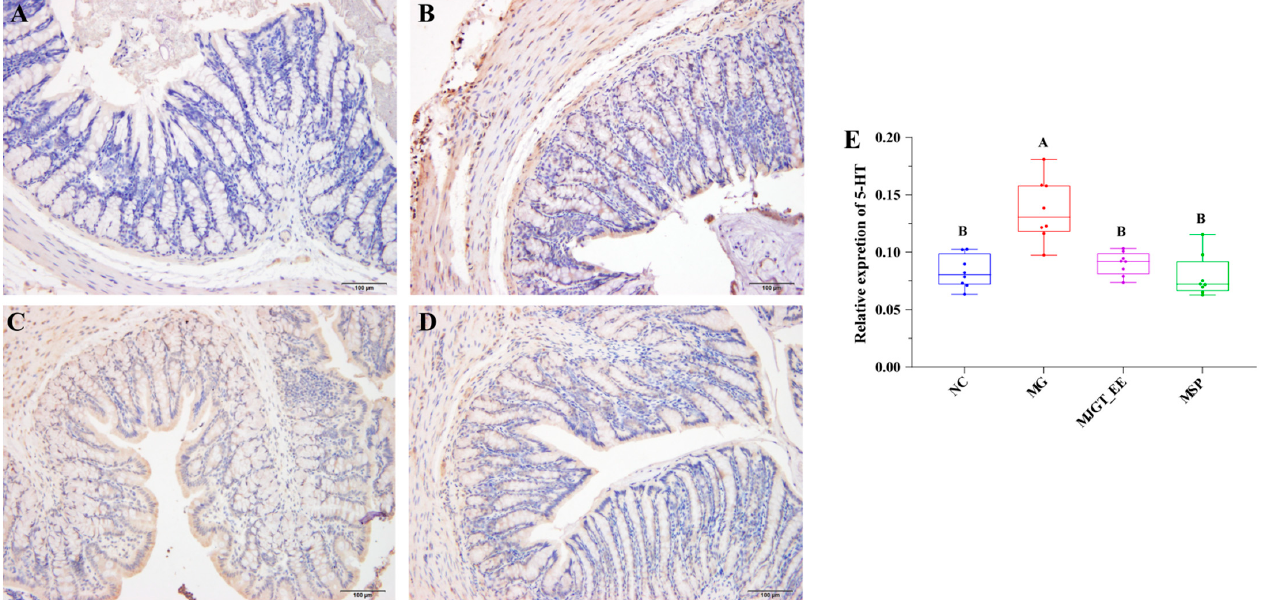
Figure 4. Immunohistochemical staining analysis to observe the effect of MJGT_EE on the colonic tissues of IBS-C rats. ( A ) The colonic tissues from normal rats; ( B ) the colonic tissues from rats with IBS-C; ( C ) the colonic tissues of IBS-C rats after 30 days of MJGT_EE treatment; ( D ) the colonic tissues of IBS-C rats after 30 days of MSP treatment; ( E ) the relative expression of 5-HT. Capital letters above the bar indicate the difference significance at the 0.01 level. ( n = 8 for each group). NC: negative control group; MG: model group, MSP: mosapride group, MJGT_EE: Mao Jian Green Tea ethanol extract group; 5-HT: 5-hydroxytryptamine.